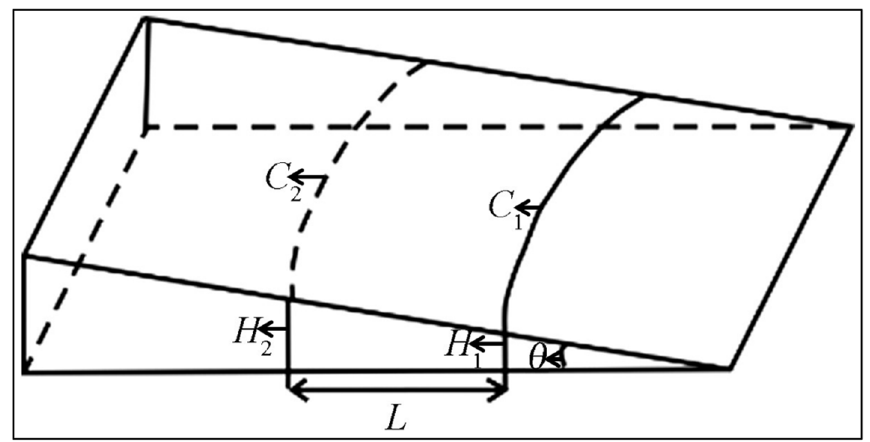
Figure 3. Migration model used for the tidal geometric correction.